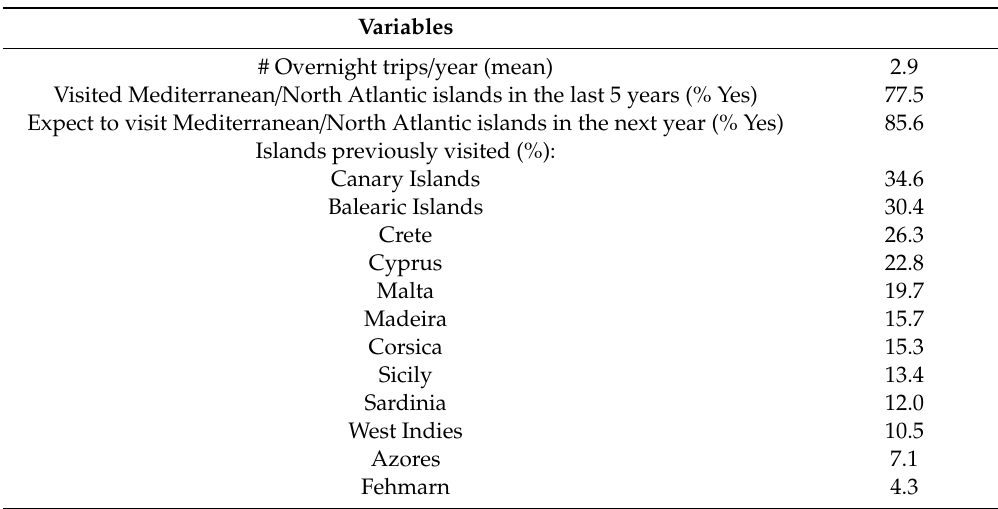
Table 3. Previous visits and disposition towards EU island